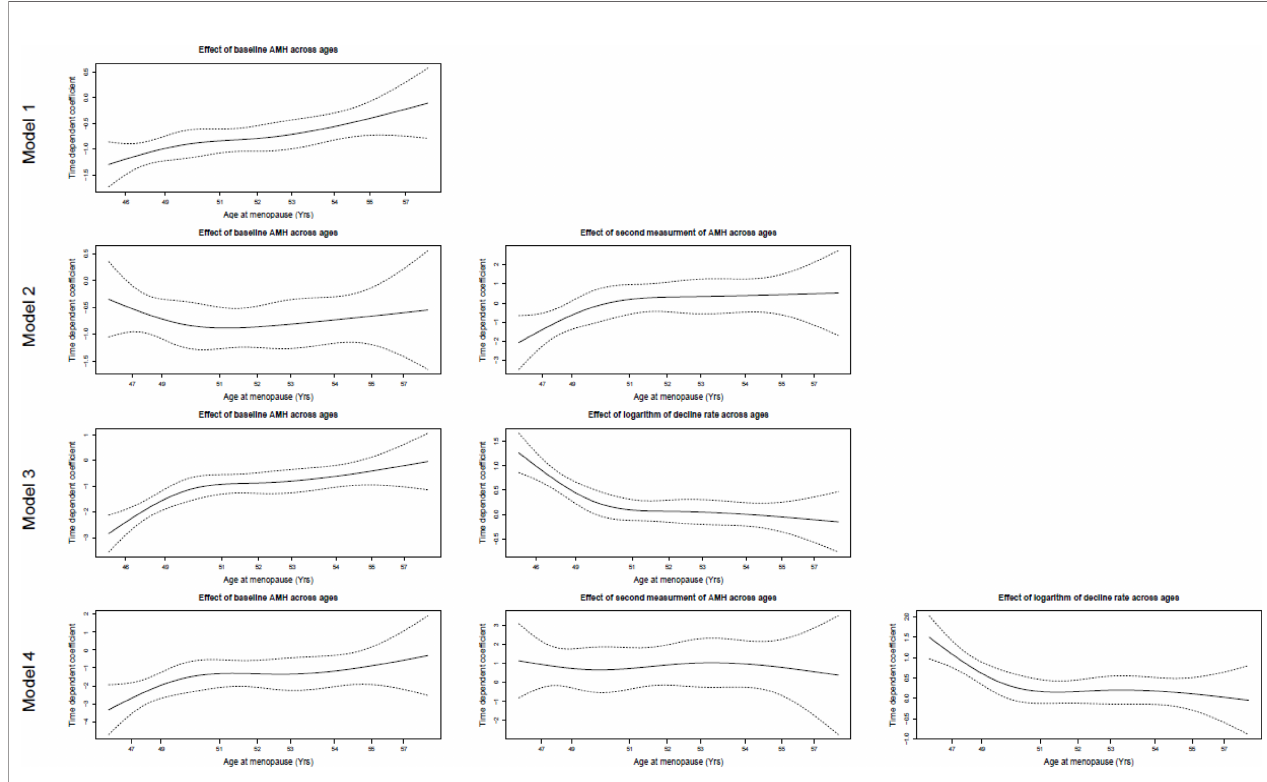
FIGURE 2 | The visual assessment of proportional hazard assumption for Cox regression models. Model 1: The effect of baseline AMH measurement on survival time adjusted by age at baseline and storage time for baseline AMH. Model 2: The effects of baseline and second AMH measurements on survival time adjusted by age at baseline, storage times of baseline, and second AMH measure. Model 3: The effects of baseline AMH measurement and logarithm of AMH annual decline rate on survival time adjusted by age at baseline, storage times of baseline, and second AMH measure. Model 4: The effects of baseline AMH measurement, second AMH measurement, and logarithm of AMH annual decline rate on survival time adjusted by age at baseline, storage times of baseline, and second AMH